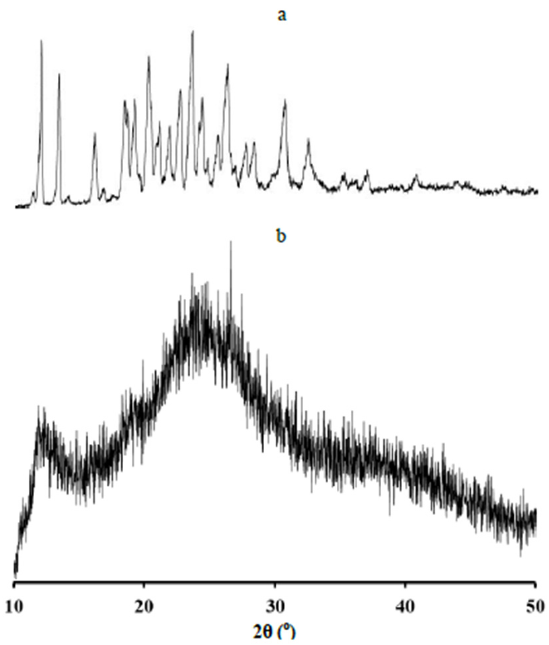
Figure 2. Characteristic diffraction peaks in PXRD of ( a ) alpha-mangostin (AM) and ( b ) water-soluble chitosan (WSC).